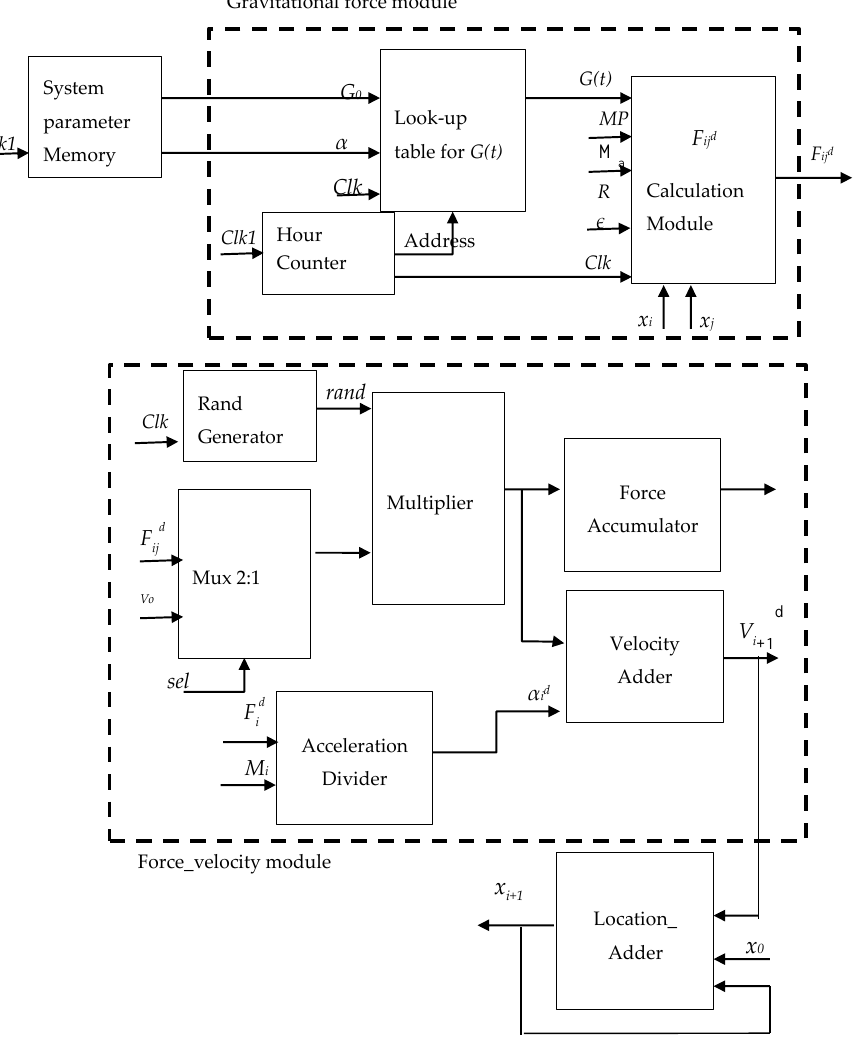
Figure 4. The proposed field programming gate array (FPGA) hardware implementation of GSA